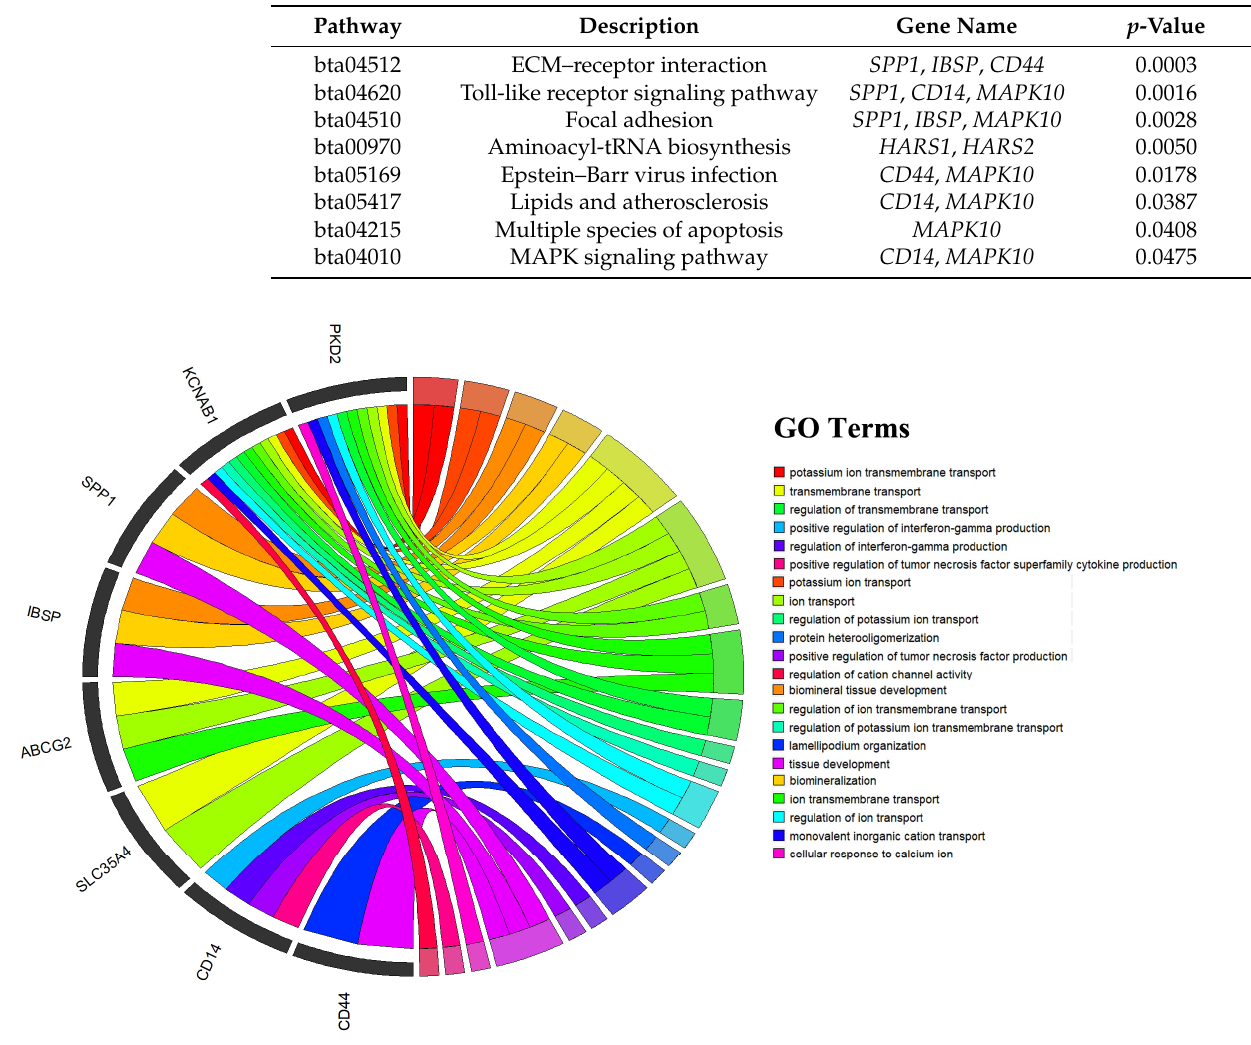
Figure 6. Gene ontology terms of genes significantly enriched for significant SNPs. A total of 22 GO terms enriched by 8 genes were identified in the circus layouts following quality control ( p < 0.05).